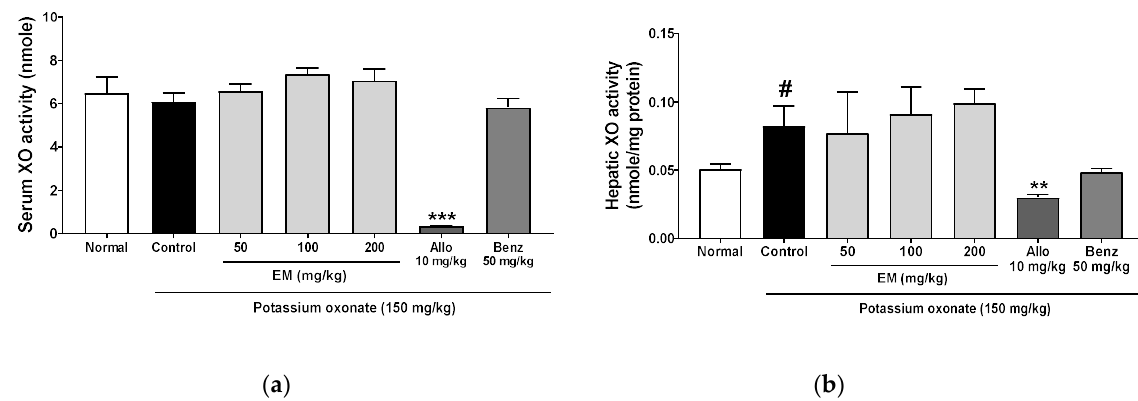
Figure 4. The effects of EM on xanthine oxidase activity in rats with PO-induced hyperuricemia. ( a ) Serum XO activity. ( b ) Hepatic XO activity; (n = 5 per group). Allo, allopurinol; Benz, benzbromarone. # p < 0.05 vs. the normal group; ** p < 0.01 and *** p < 0.001 vs. the PO group.